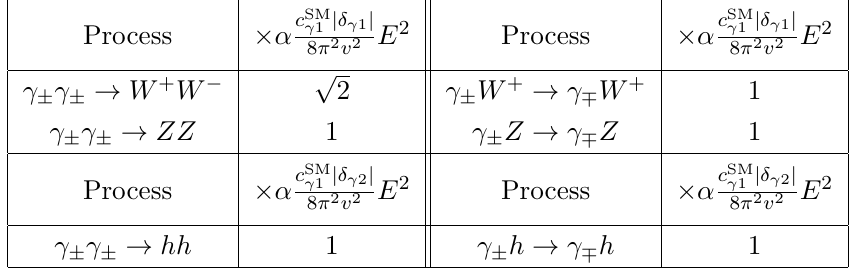
| ˆ M | of the 4-body model-independent unitarity-violating processes arising from the modification of the Higgs coupling to γγ .